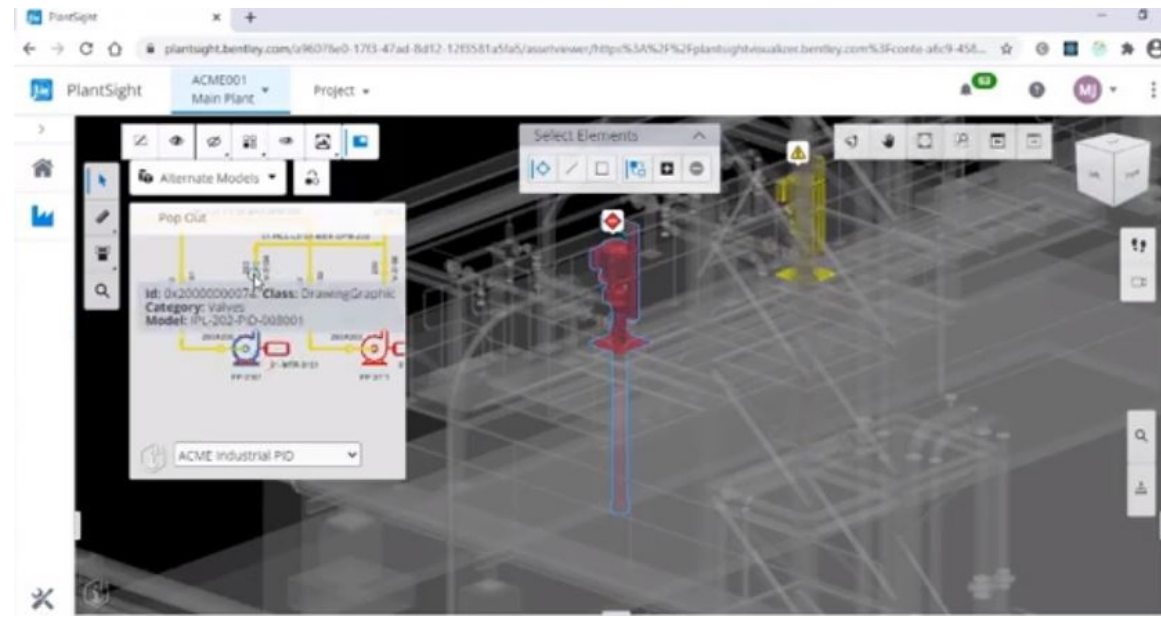
Figure 24. Typical asset integrity management using PlantSight by Bentley Systems.